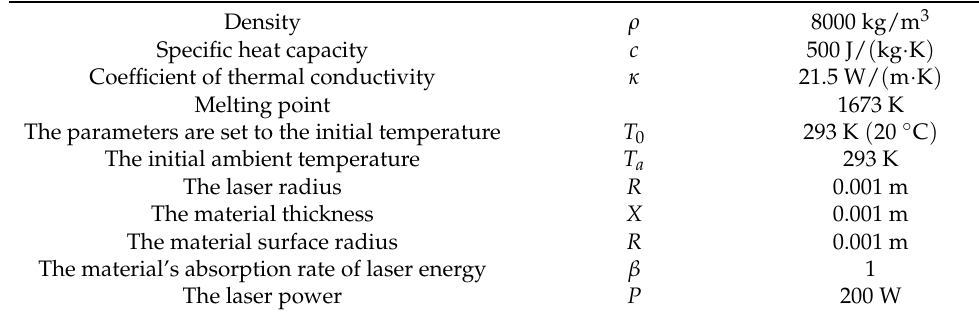
Table 5. The thermal property parameters of 316 stainless steel.